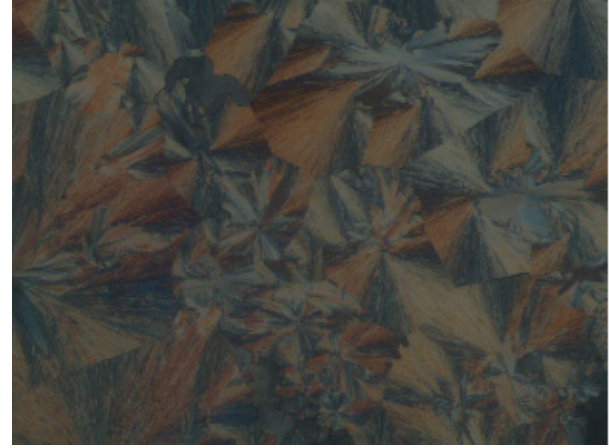
Figure 4. SmA texture of IIa derivative during cooling scan at 85 °C.